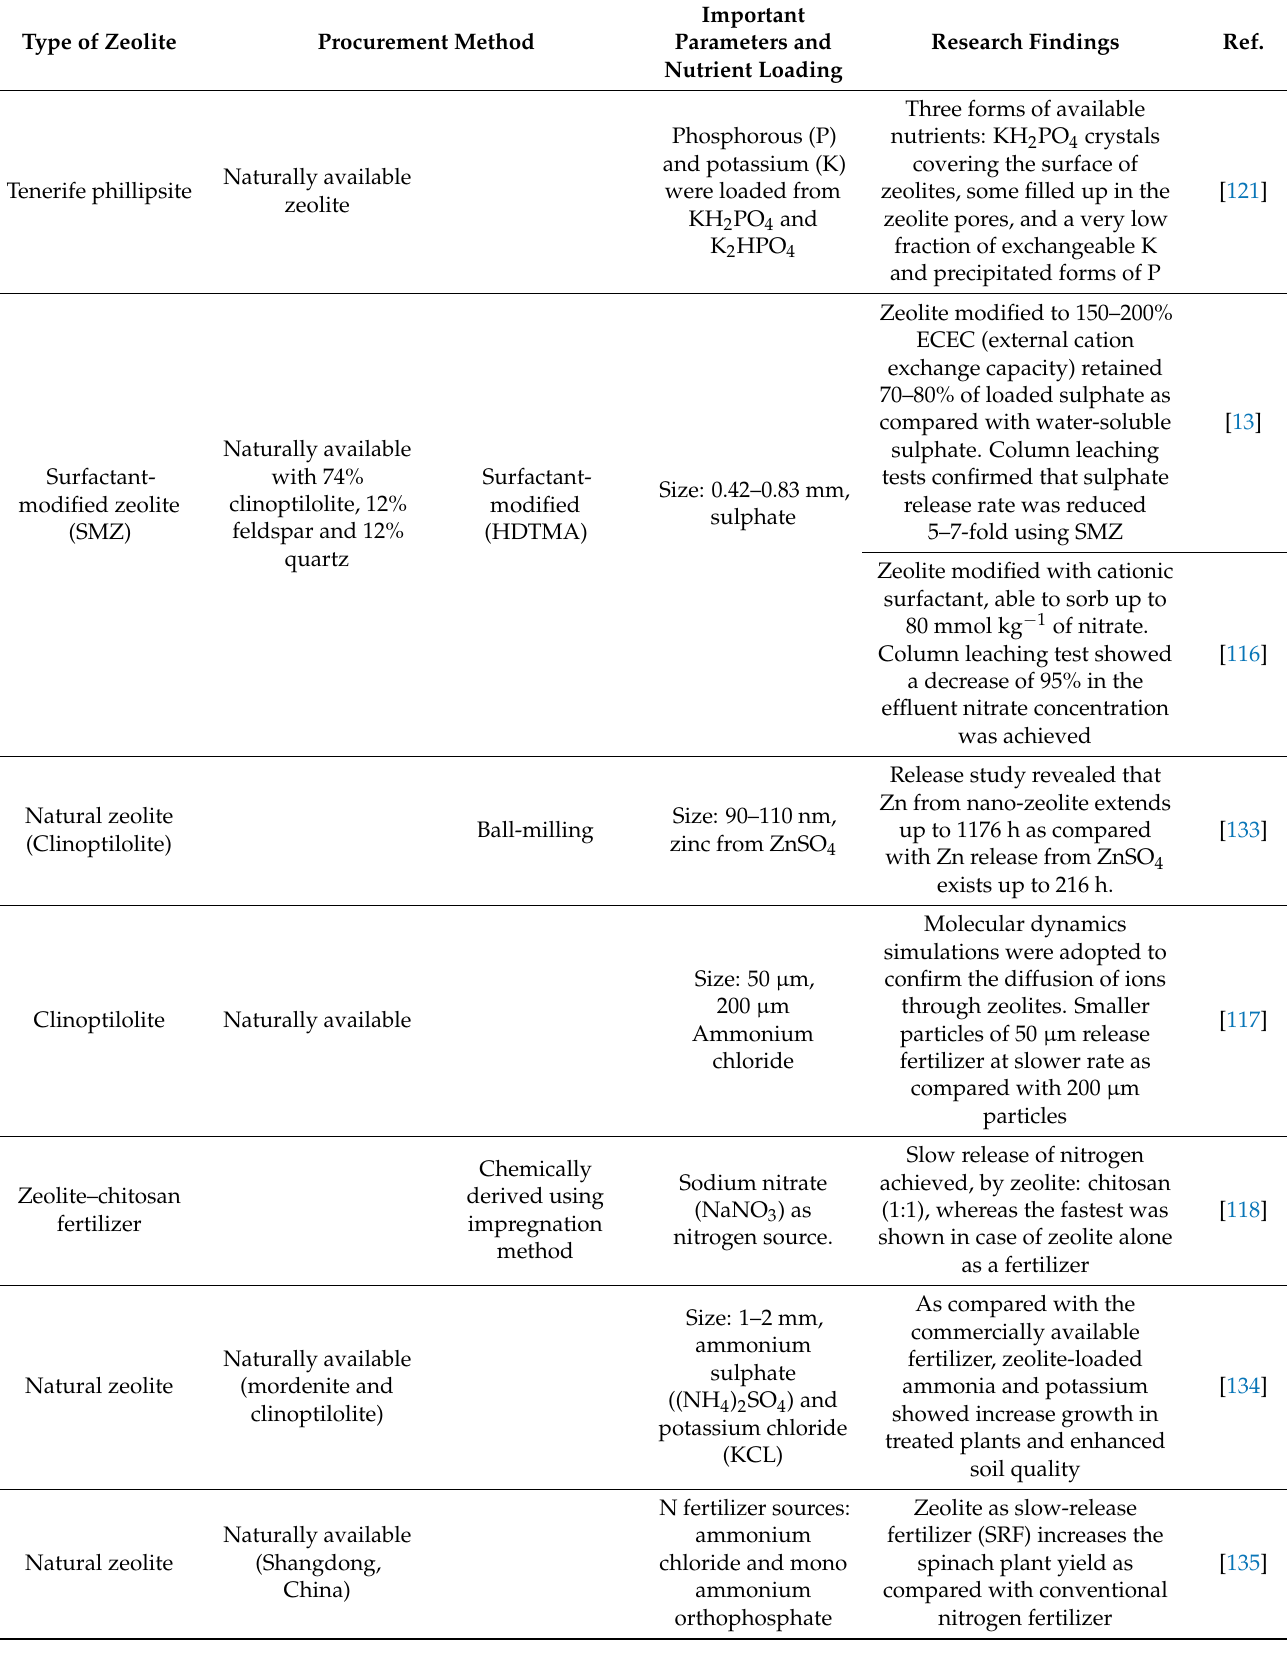
Table 2. Zeolites as carriers of micro- and